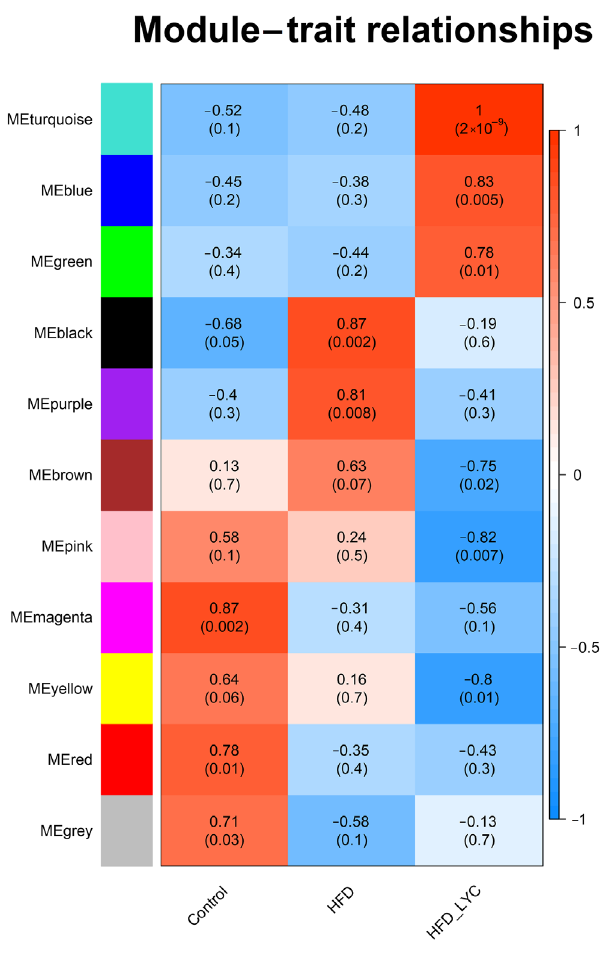
Figure 3. Module–trait relationship. Each row represents a module eigengene and each column represents a trait. Each cell includes the corresponding correlation and p -value. HFD, high-fat diet; HFD-LYC, high-fat diet + lycopene.